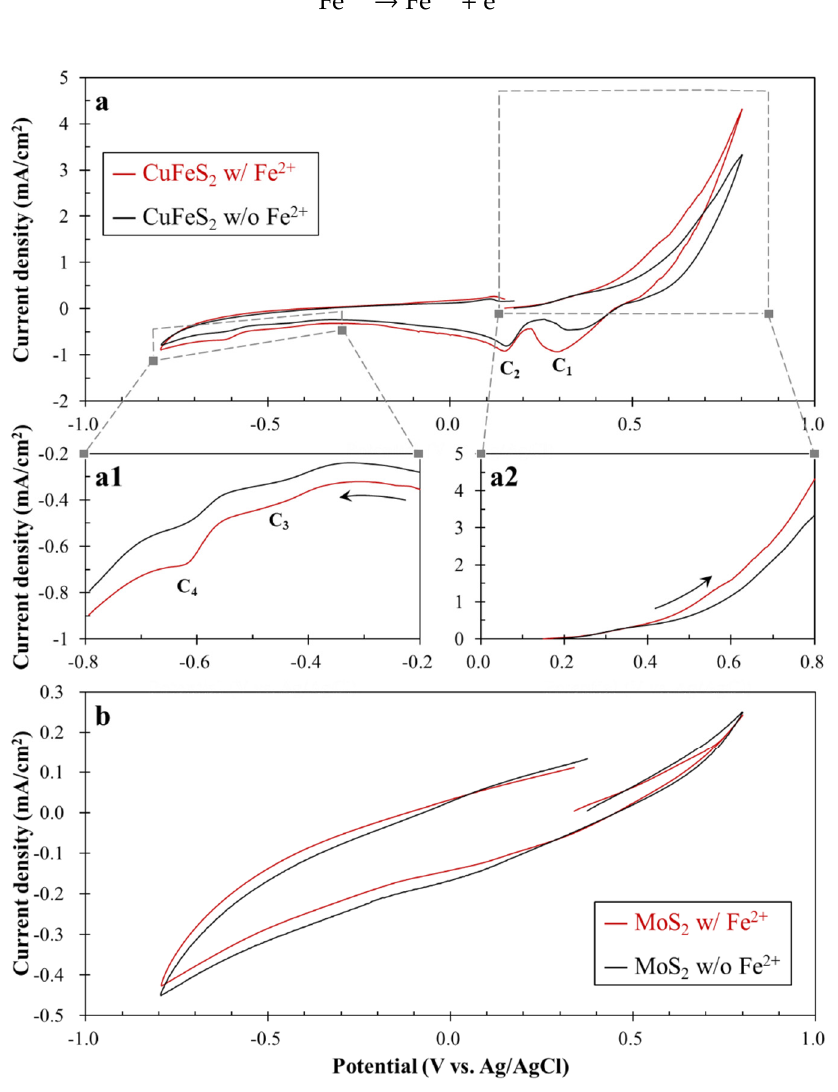
Figure 3. Cyclic voltammograms of ( a ) chalcopyrite ( a1 : cathodic scan from − 0.2 to − 0.8 V, a2 : anodic scan from open circuit potential (OCP) to 0.8 V) and ( b ) molybdenite in the absence and presence of 1 mmol / L Fe 2 + . Note that the arrows in Figure 3(a1,a2) denote the sweep direction.